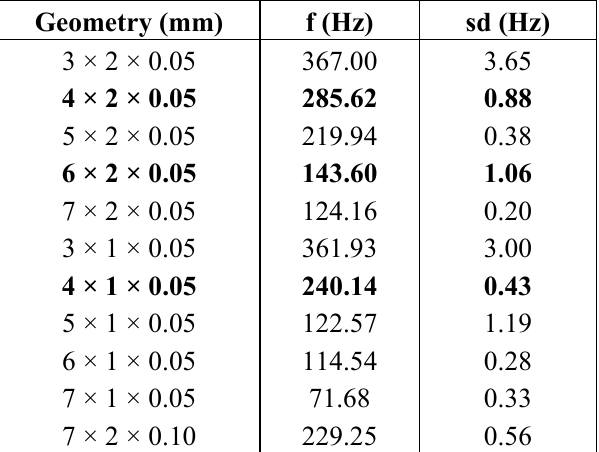
Table 3. Results of the eigenfrequency measurement as mean value (f) and associated standard deviation (sd) of different oscillators (bolded values are the parameters chosen for further